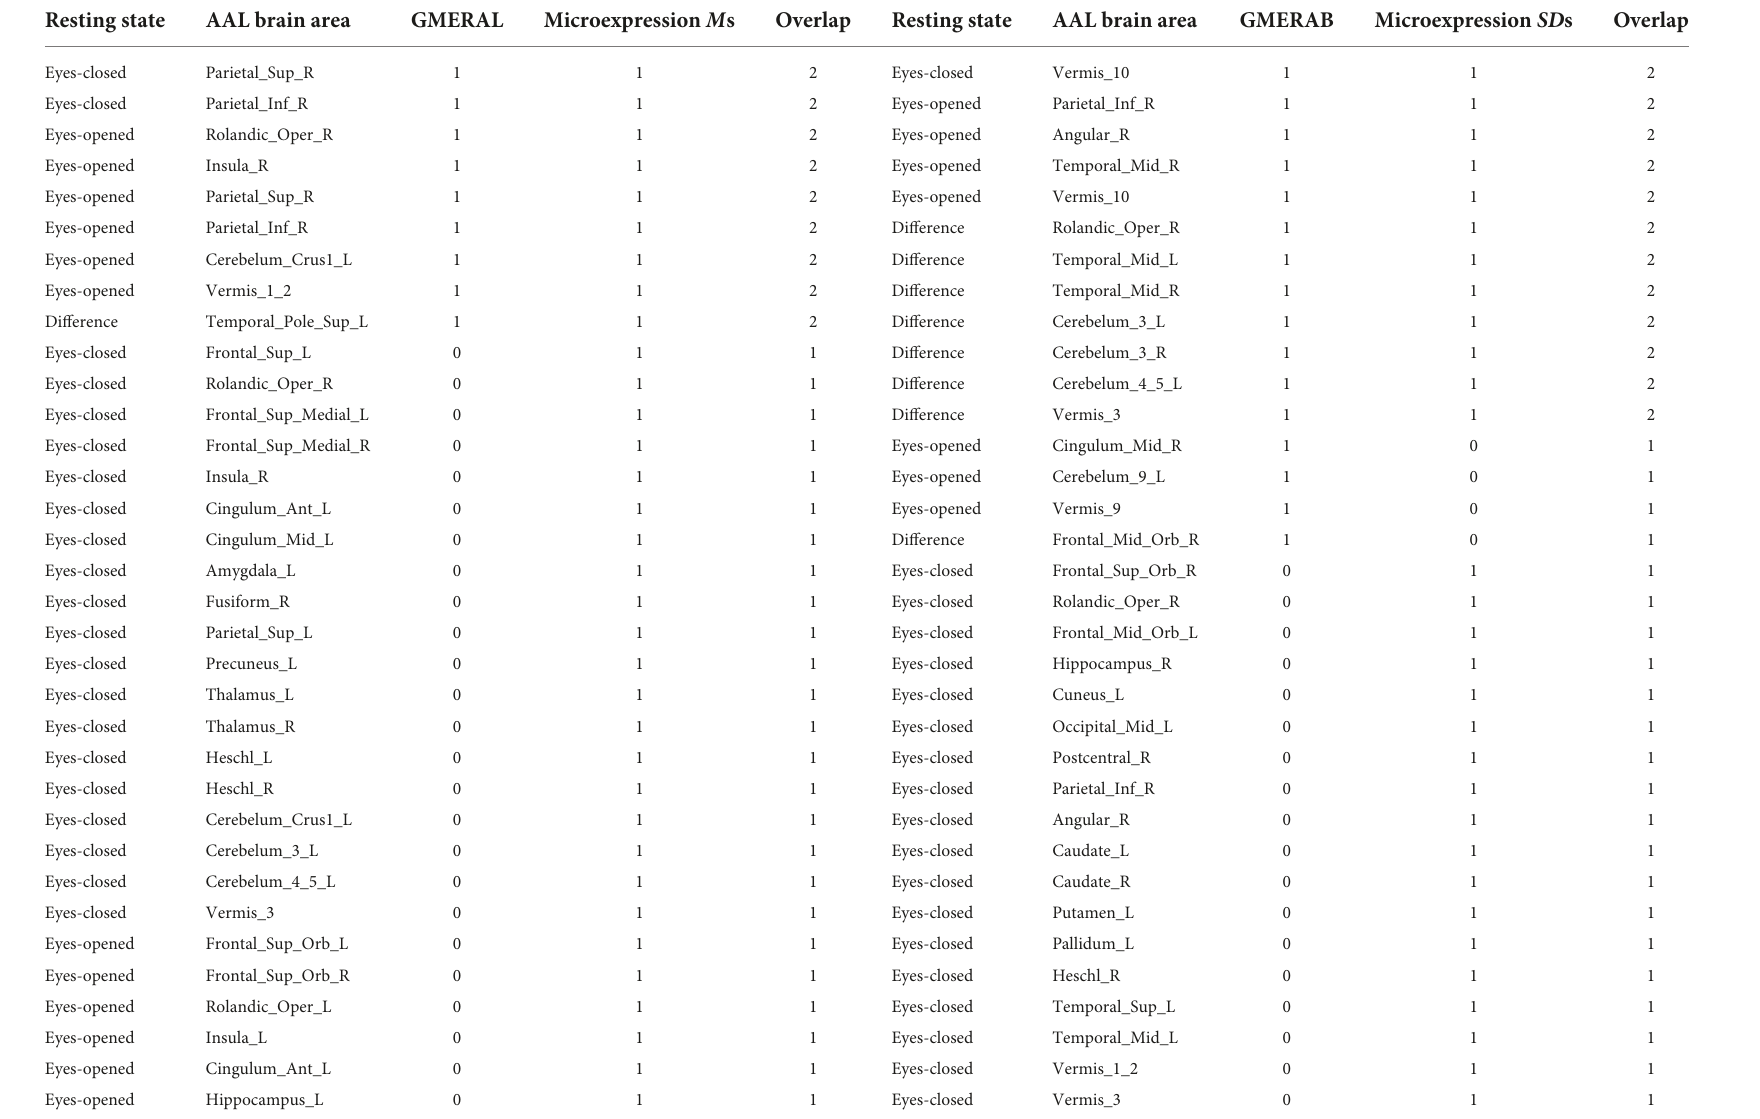
TABLE 5 The overlap of relevant brain areas between GMERAL and microexpression M s, and between GMERAB and microexpression SD s. Resting